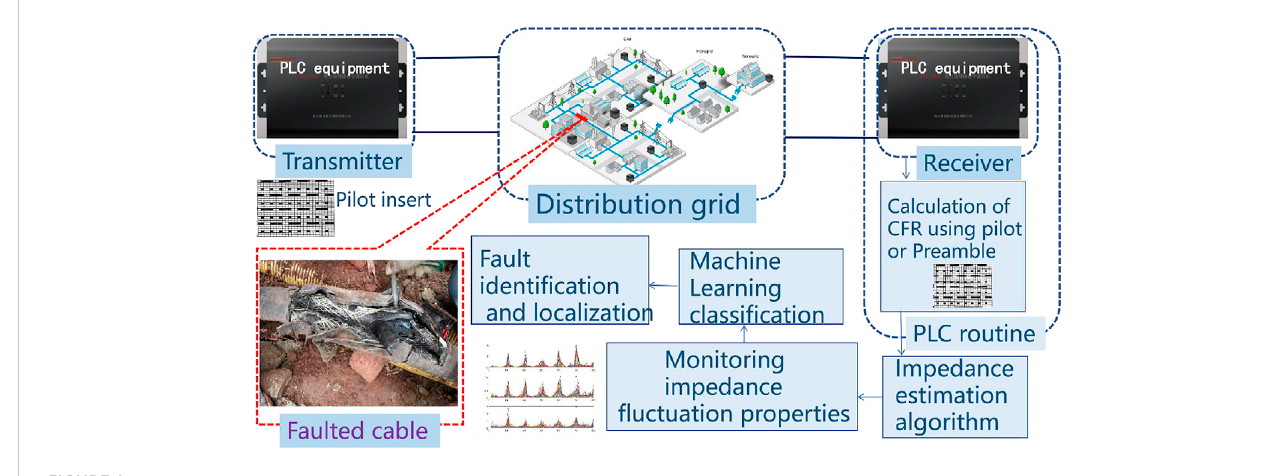
FIGURE 1 Overall scheme diagram.